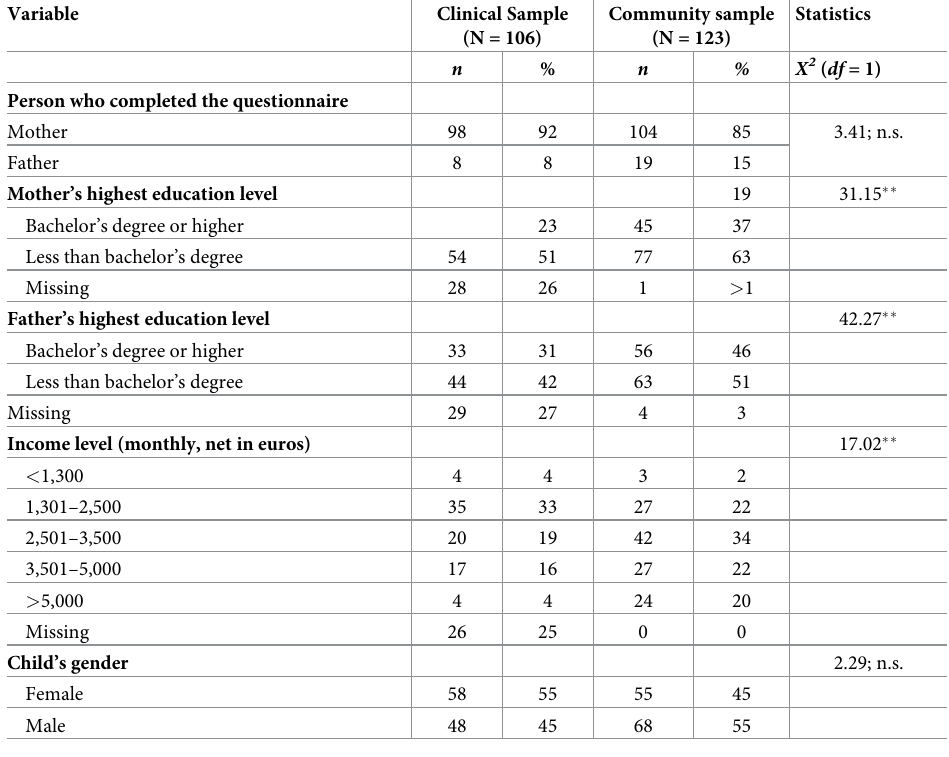
Table 2. Sociodemographic data of the parents of the Clinical Sample (ClinS) and the Community Sample